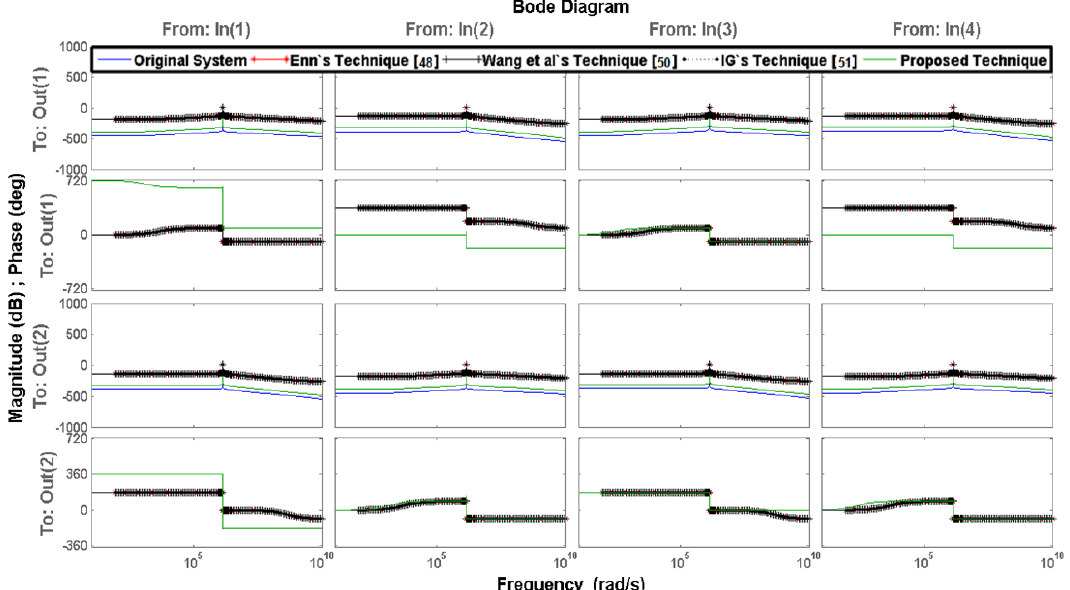
Figure 6. Frequency response Bode plot (magnitude and phase) in the given frequency weights of 2nd order for Example